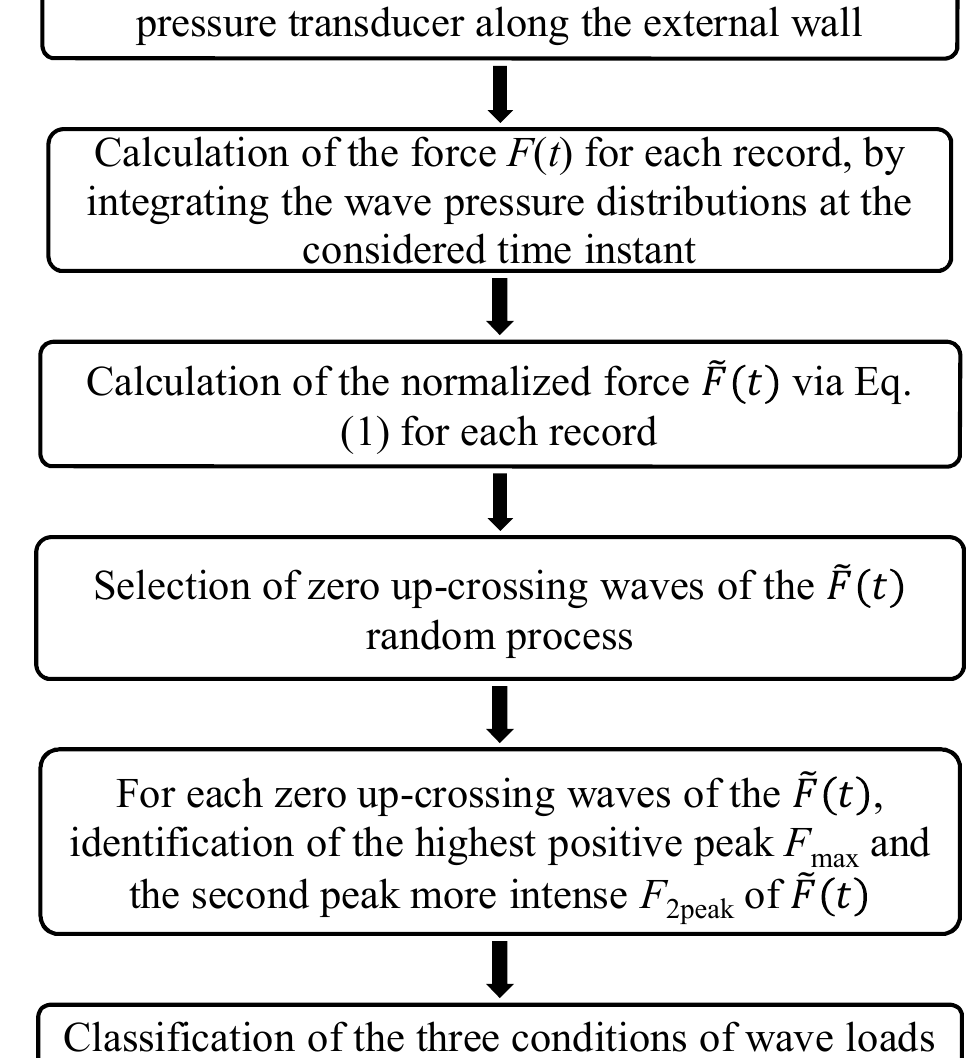
Figure 2. Flow chart of the methodology applied for the analysis of data on small-field experiment. When the waves are perfectly reflected, a “Quasi-Standing (QS)” wave pattern results, characterized by two double positive peaks of equal intensity, when a high wave crest impacts to the breakwater. When the breaking phenomena is realizing on the structure or in front of it, the wave pressure in the time domain shows an asymmetrical trend with two peaks with different intensity, with the first one greater than the second [3]. The impulsive wave impacts in these configurations are distinguished in “Slightly Breaking Waves